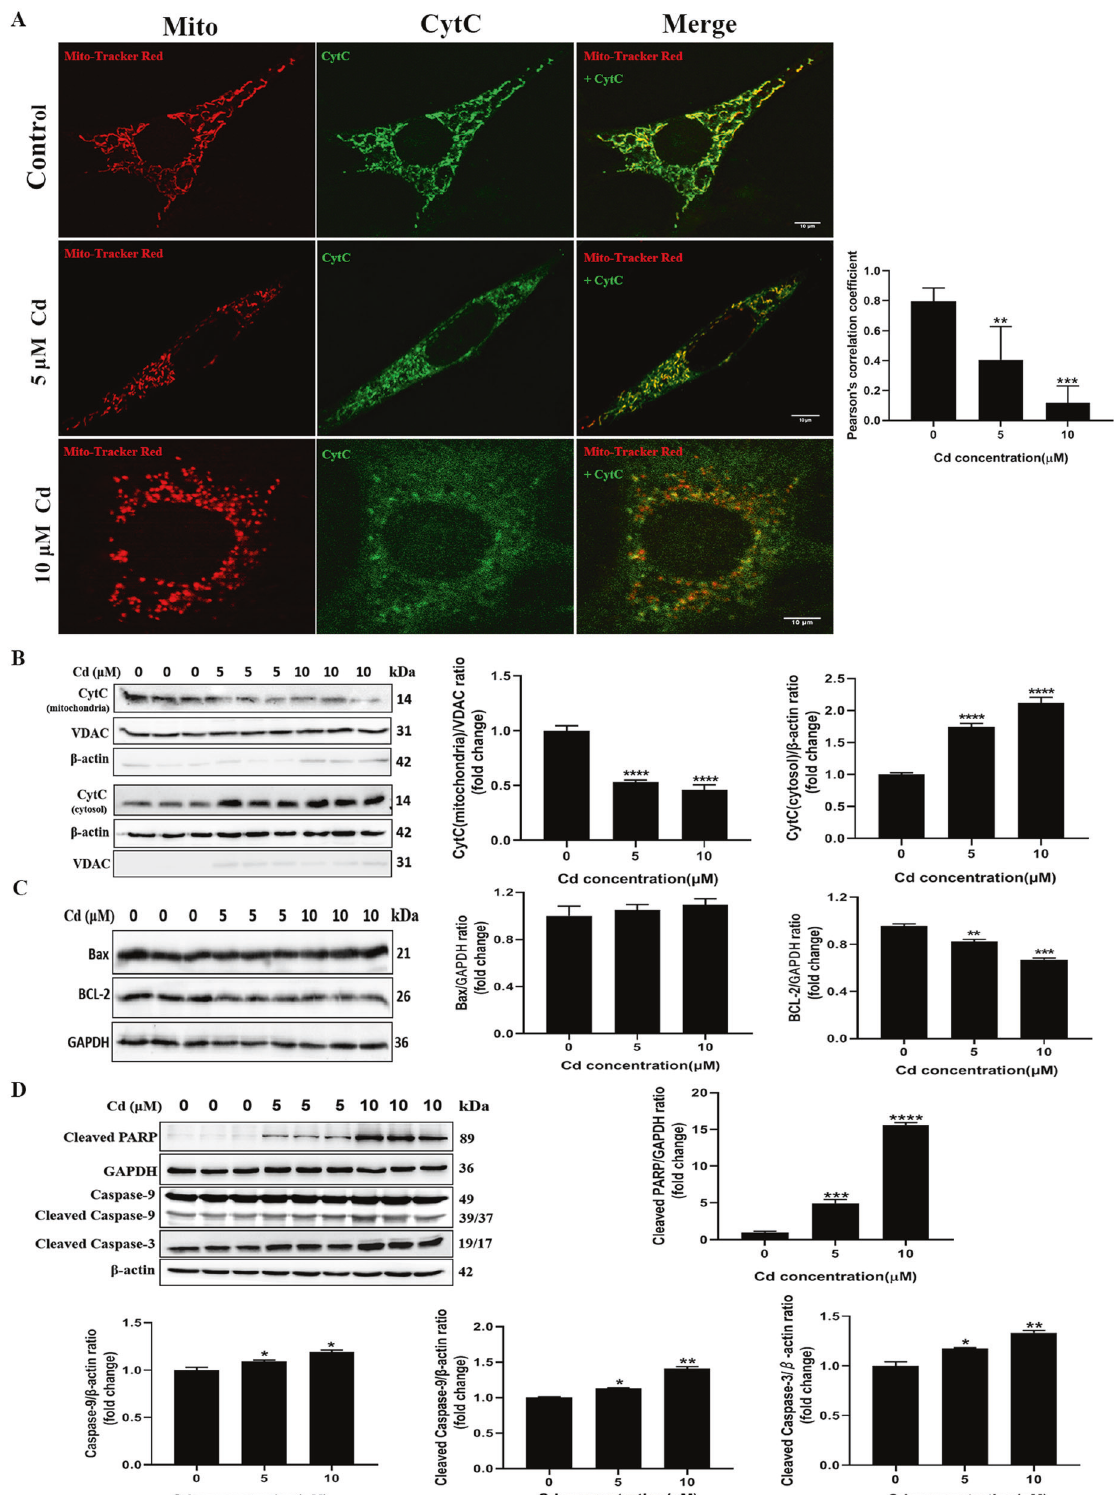
Fig. 5 Cadmium induced the release of cytochrome c from the mitochondria into the cytosol of TM3 cells and promoted apoptosis. A , B The cellular distribution of cytochrome c was analyzed by immuno fl uorescence and Western blotting after the cells were treated with cadmium for 24 h. The cells were stained with mitochondrial probes (Mito-Tracker Red CMXRos), incubated with anti-CytC (Green) and then observed by laser confocal microscopy (100x). Pearson ’ s correlation coef fi cient was used to assess the colocalization between mitochondria and cytochrome c. VDAC and β -actin were used as internal references for mitochondrial and cytosolic fractions, respectively. C , D The levels of apoptosis-related proteins Bax, Bcl-2, cleaved PARP, Caspase-9, cleaved Caspase-9 and cleaved Caspase-3 were measured by Western blot. The data represent the mean ± SD of three independent experiments (** P < 0.01, *** P < 0.001, **** P < 0.0001 vs. control).